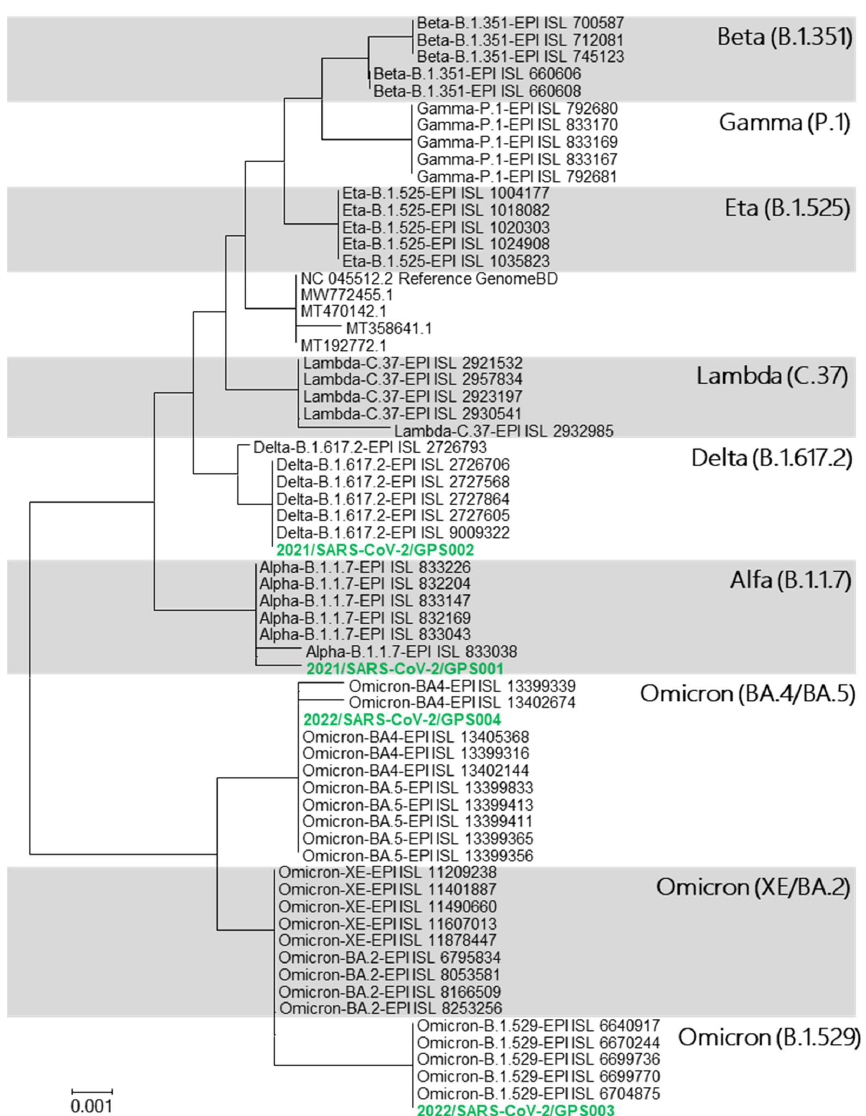
Figure 1. Phylogenetic tree displaying the relationships between the SARS-CoV-2 lineages based on the selected S-gene 921 bp fragment database. It also shows the phylogenetic affiliation of the four clinical samples (green) assayed.